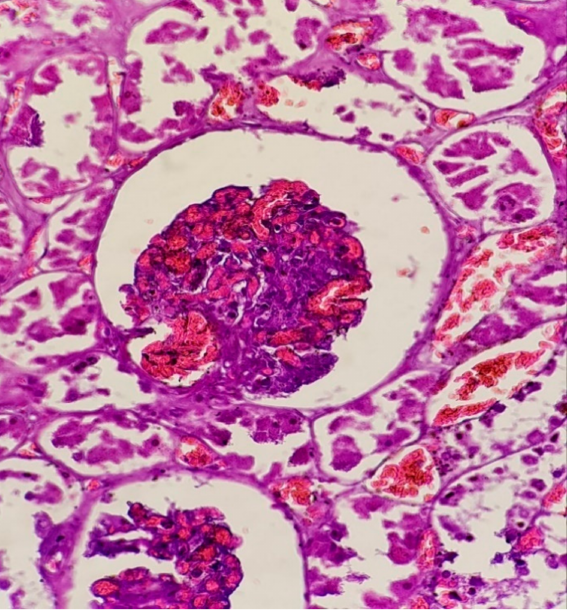
Figure 3. 400 × HE stain of maternal renal tissue demonstrating distension of glomerular filtration space, capillary loop conglomeration, glomerular stasis, and extensive tubular necrosis, especially in the proximal segments, with extravasated red blood cells.